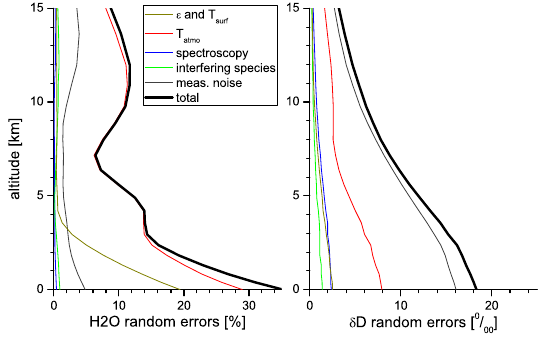
Fig. 6. Random error budgets: left panel for H 2 O and right panel for δ D.